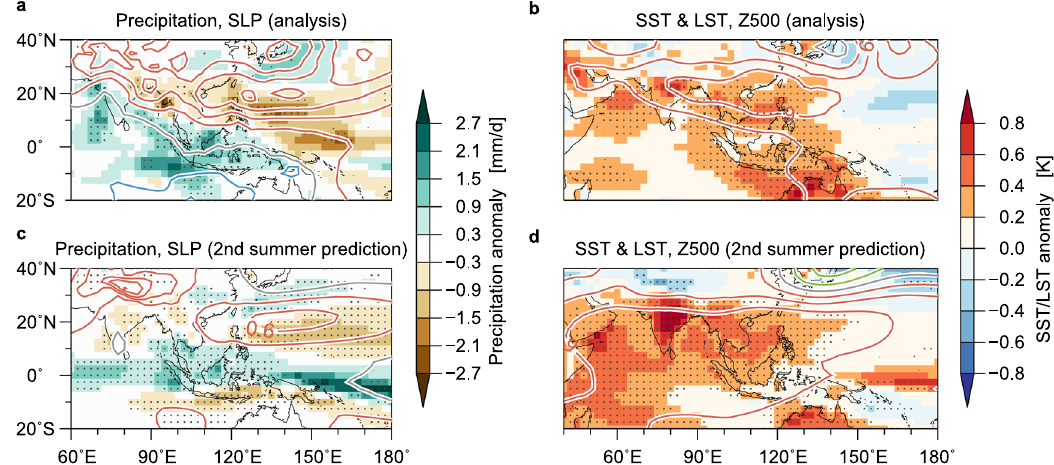
Fig. 3 The IPOC mode and its second summer prediction. Composite anomalies of the ( a , b ) observations and ( c , d ) JMA/MRI-CPS2 13-month-lead prediction for summers following major El Niño events (1983, 1992, 1998, 2003, 2010 and 2016; see text for de fi nition). a , c Precipitation (colours) and sea level pressure (SLP; contours with an interval of 0.3 hPa; red for positive, grey for zero and blue for negative). b , d SST over the ocean and land surface (2 m air) temperature (LST) over land (colours) and 500 hPa geopotential height (Z500; contours with an interval of 3 m; red for positive, grey for zero and green for negative). Stippled regions are statistically signi fi cant at the 5% level based on a bootstrap method (10,000 resamplings).